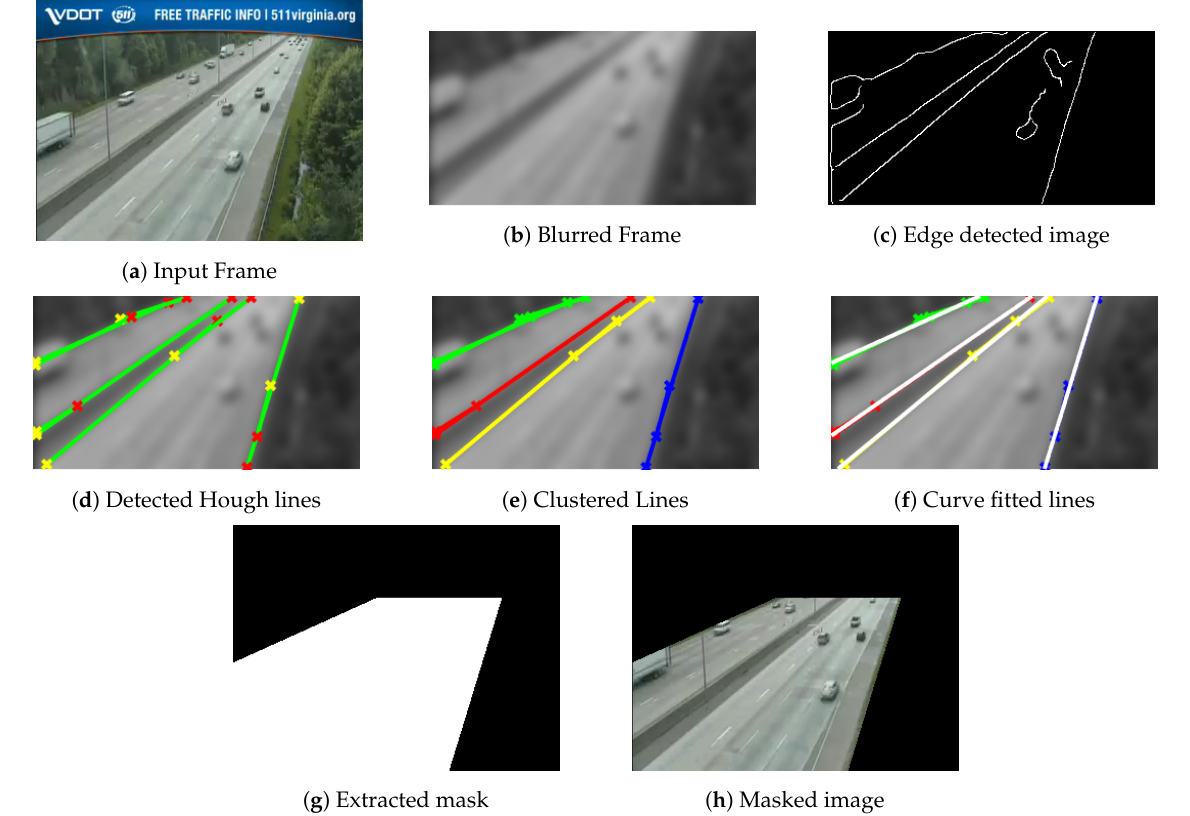
Figure 6. Different output for ROI extraction pipeline stages for Video